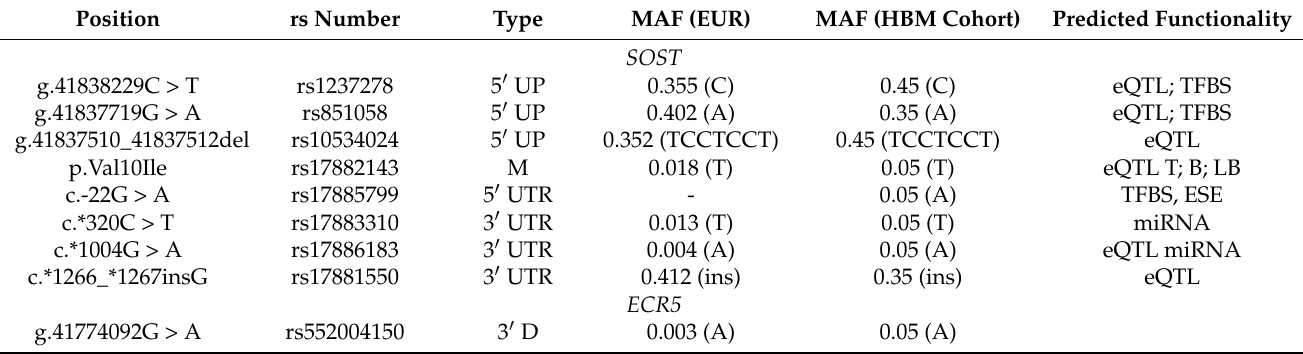
Table 1. Variants in SOST and ECR5 found in women with an HBM